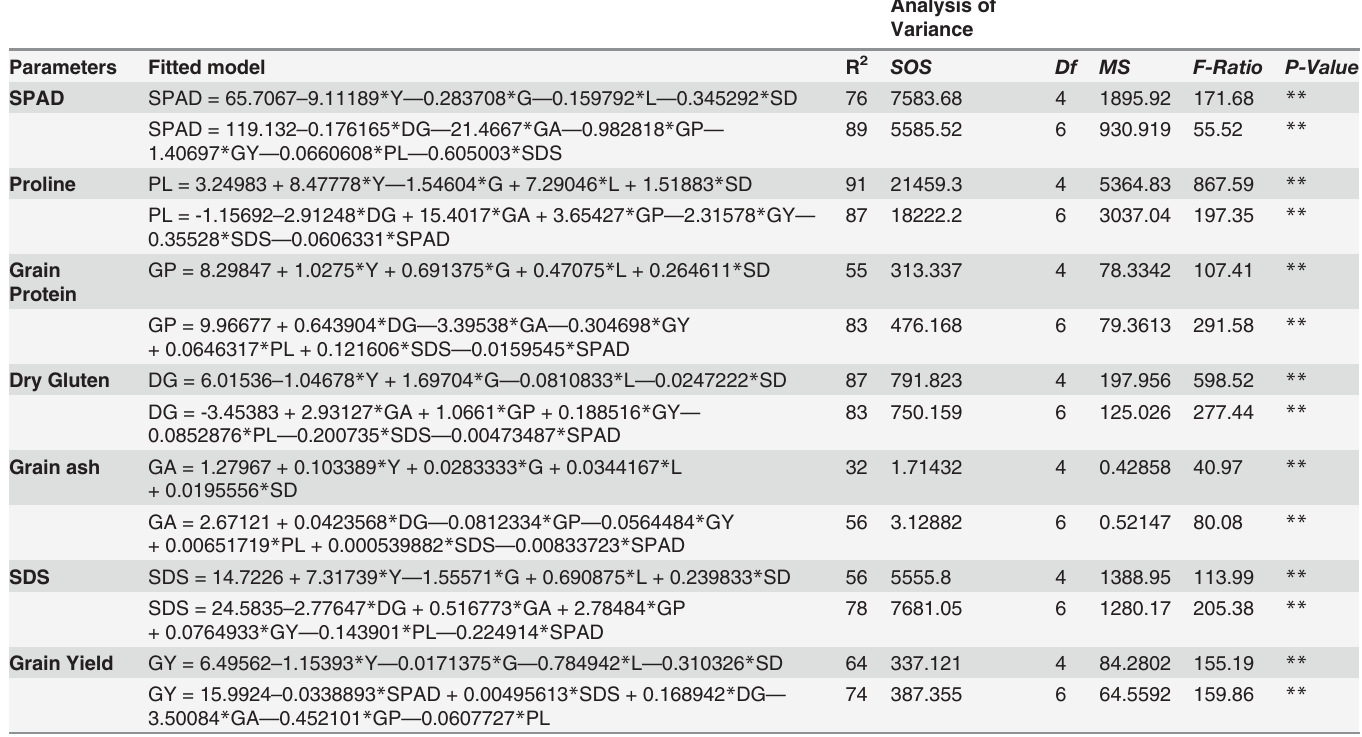
Table 3. Multivariate regression fitted model to study relationship between physiological, grain quality traits, yield of spring wheat and treatments.